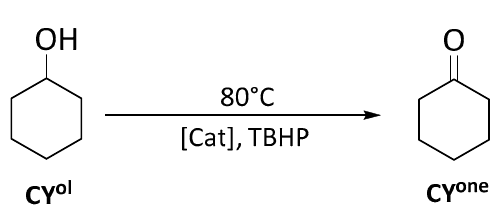
Figure S1 : Powder X-ray di ff raction diagrams of SiO 2 (blue), SiO 2 @PW (orange) and SiO 2 @PMo (grey)